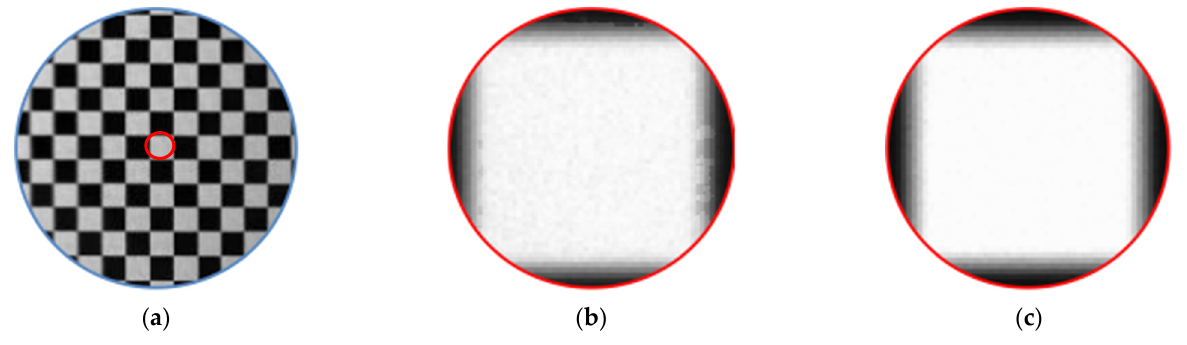
Figure 4. Resampling: assign the gray value of the image to be corrected to the standard pixel array according to the recorded coordinates.